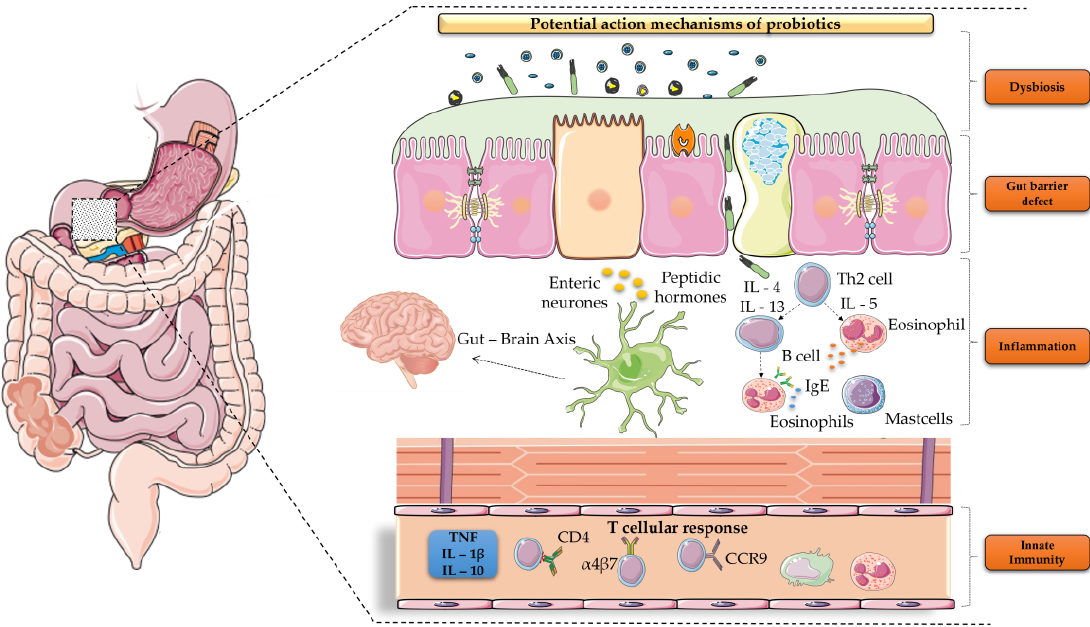
Figure 1. Putative mechanisms of probiotics involvement in FD treatment.